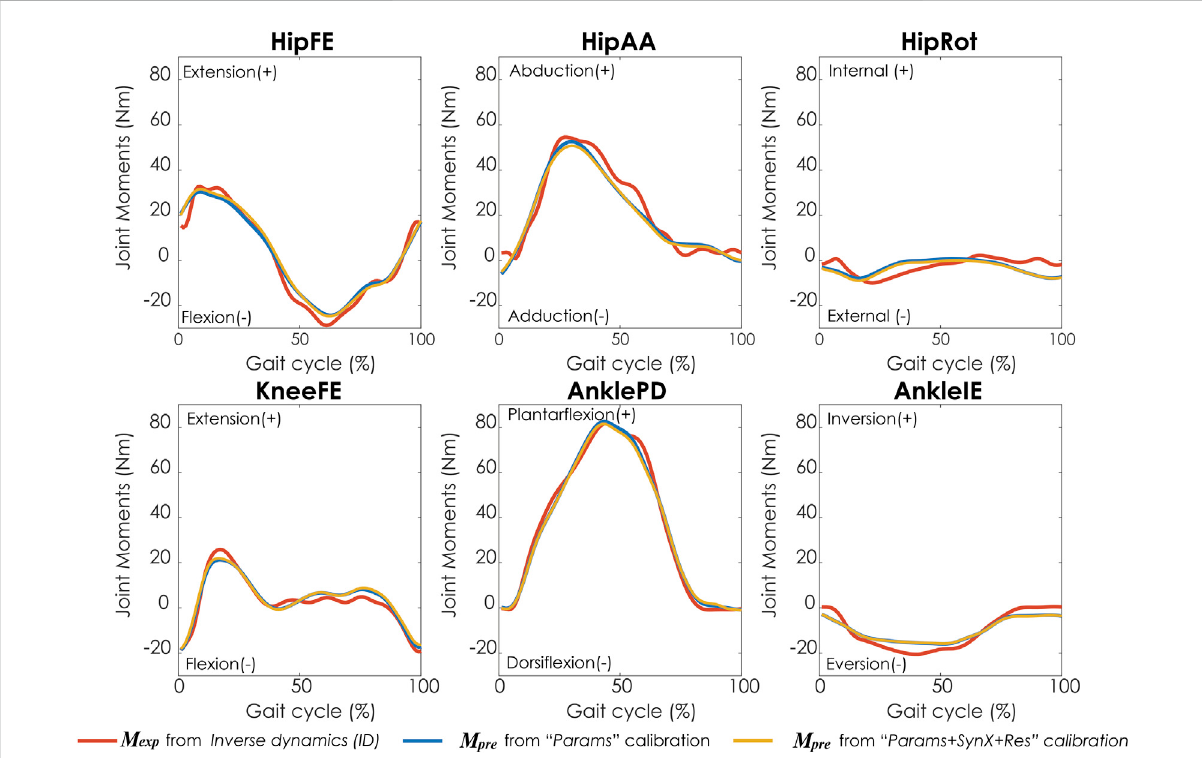
FIGURE 4 Averagejointmoments acrosscalibration trialsandsubjectsfrominversedynamics(inred), “ Params ” calibration (inblue),and “ Params +SynX+ Res ” calibration (in yellow). The results for “ Params + SynX + Res ” calibration were generated with the best methodological combination for calibration conditions (trial-speci fi c unmeasured and speed-speci fi c residual synergy vector weights with 6 synergies). For “ Params + SynX + Res, ” residual excitations werecalibrated to improve theprediction ofunmeasured muscle excitations butnot usedto calculate jointmoments. Data are reported for the complete gait cycle, where 0% indicates initial heel-strike and 100% indicates subsequent